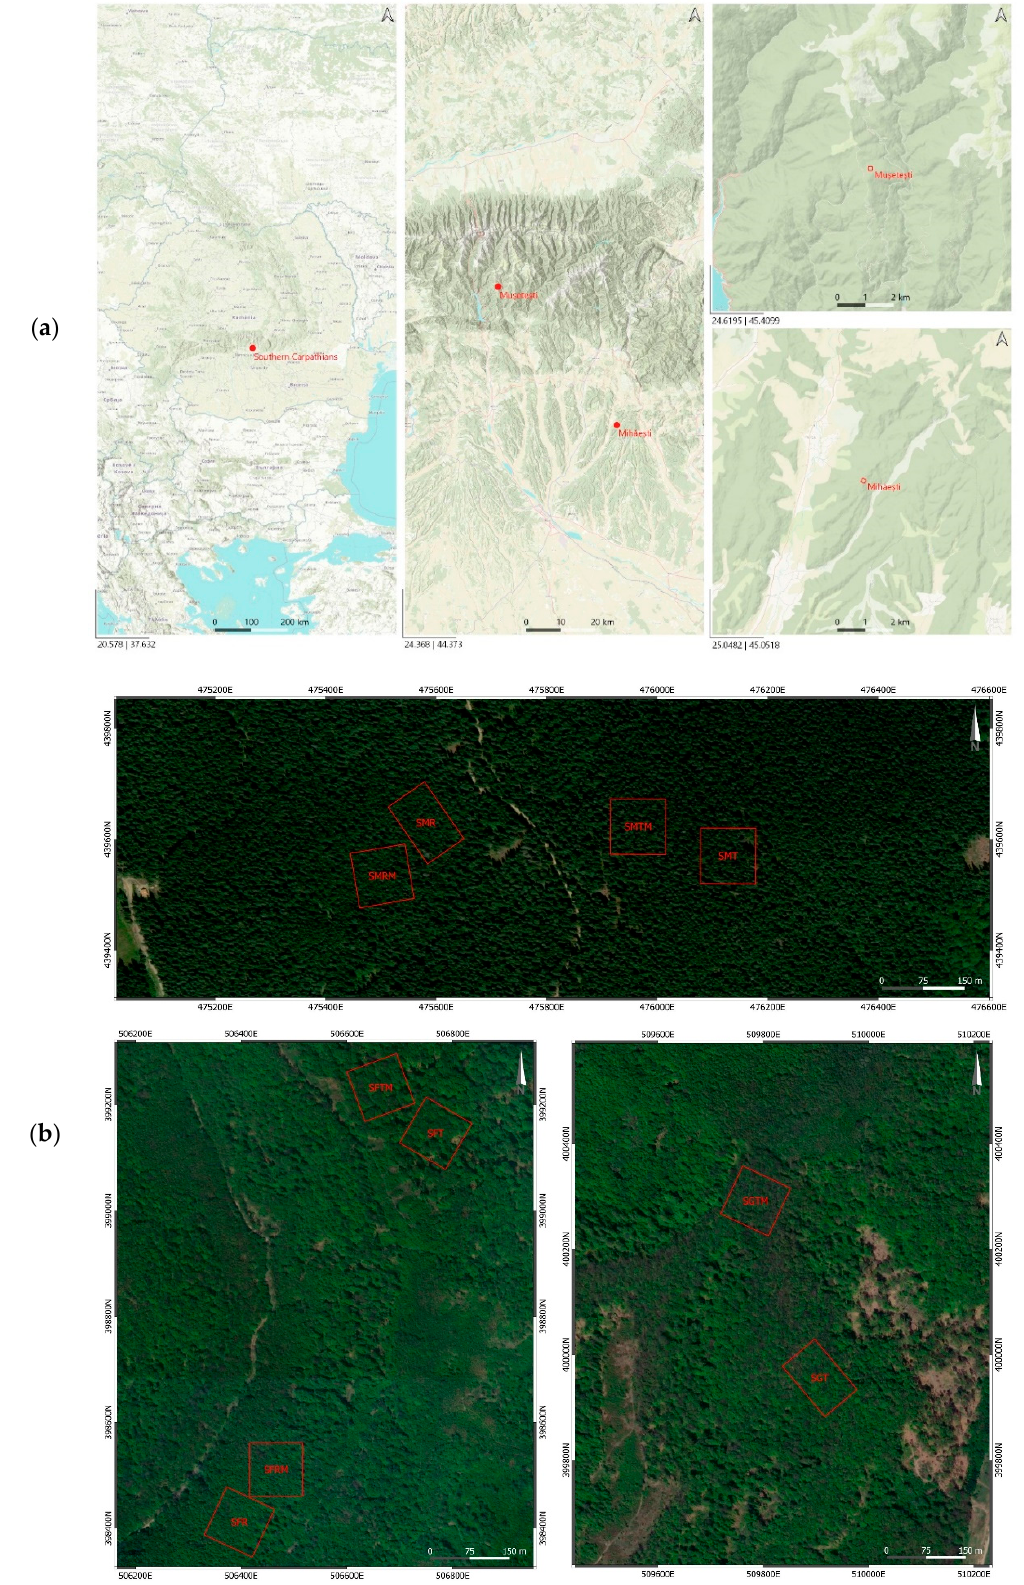
Figure 1. ( a ) Location of the sampled forest stands, ( b ) detailed position (coordinates in WGS 84 projection system). Both deciduous and coniferous forest plots were considered in the process of assessing the applicability of the studied methods as well as in the evaluation of the